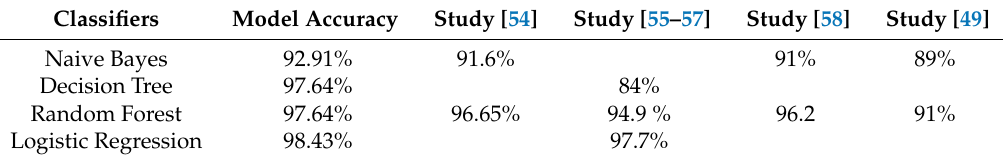
Table 3. Result of scenario 1 and comparison with other studies.